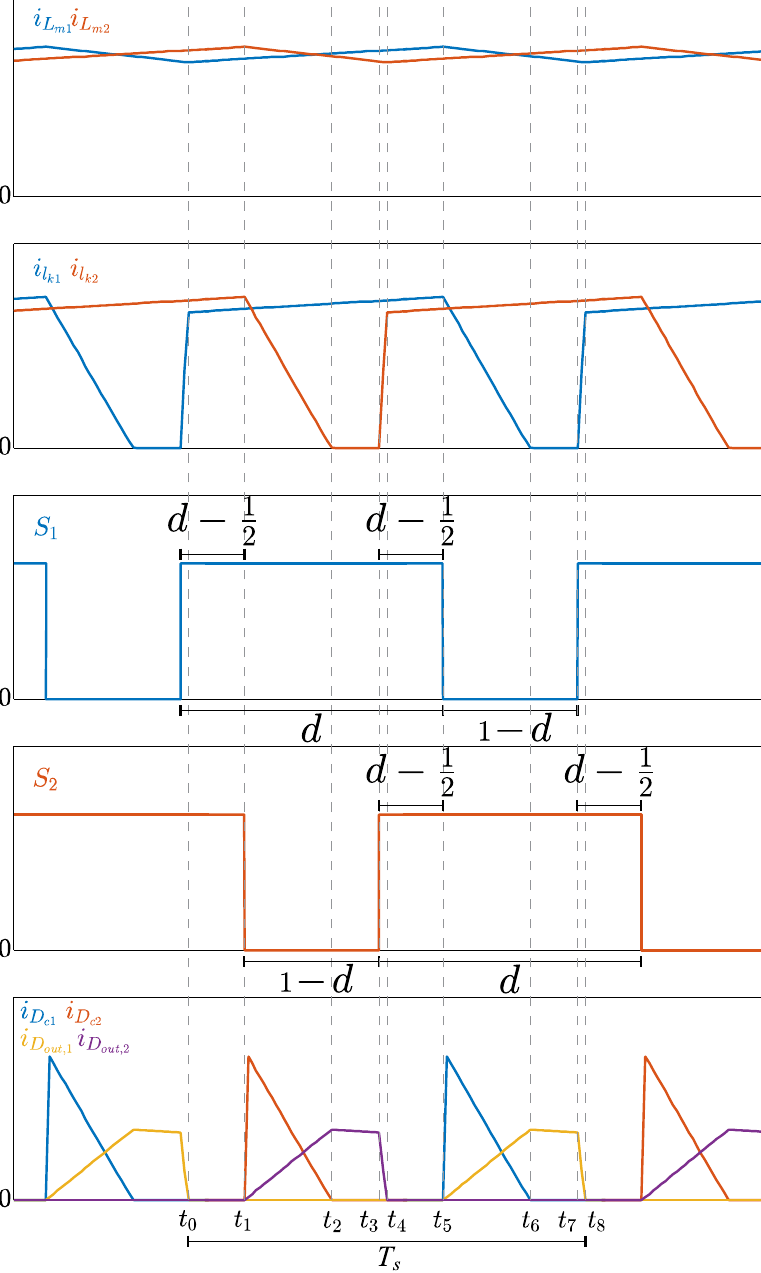
Figure 2. Inductances, diode currents’ waveforms, and gate